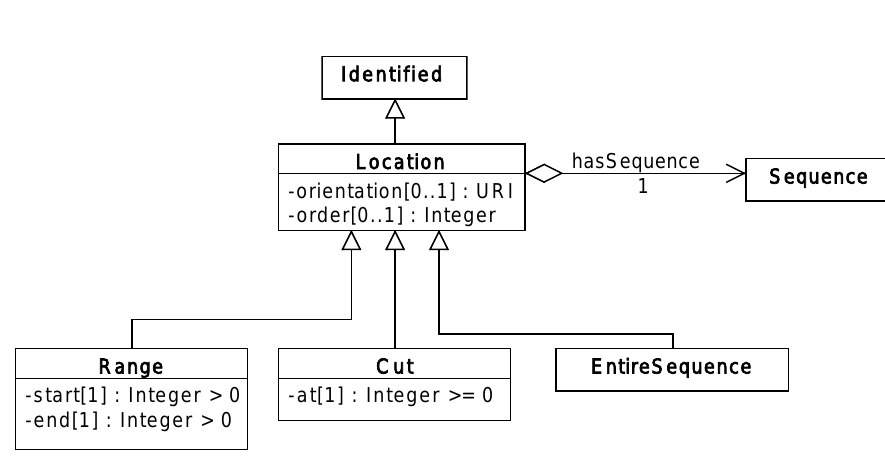
Figure 10: Diagram of the Location class and its associated